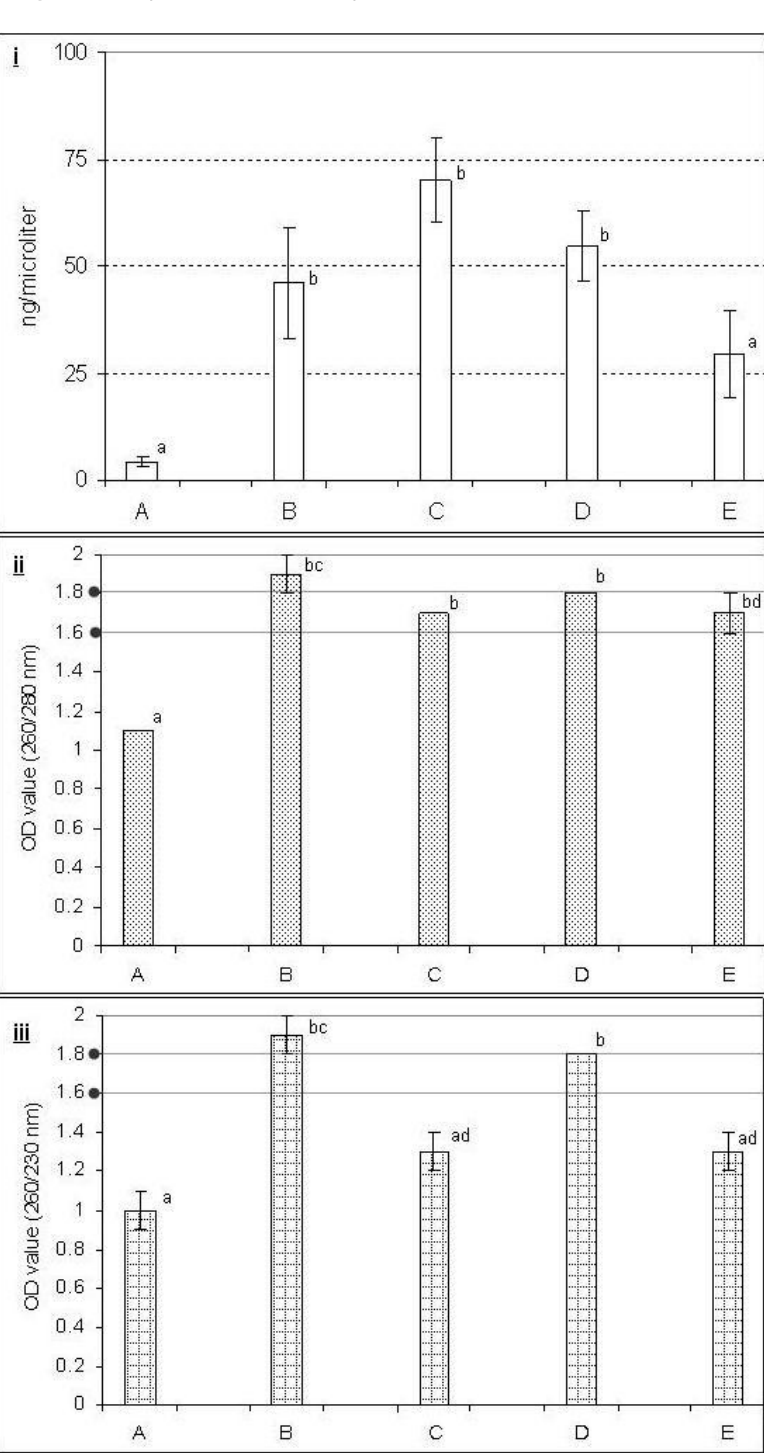
Figure 1. Effect of different lysis buffers ( A , B , C , D and E ) on DNA yield ( i ) and purity ( ii and iii ) from mature date palm leaf. Bar represents standard error of the mean. OD, Optical density; * Yield, F = 7.14, P = 0.002; ** OD value (260/280 nm), F = 41.54; P = 0; *** OD value (260/230 nm), F = 15.77, P = 0; Values expressed by different letters on the bars are significantly different (Tukey test, 5%